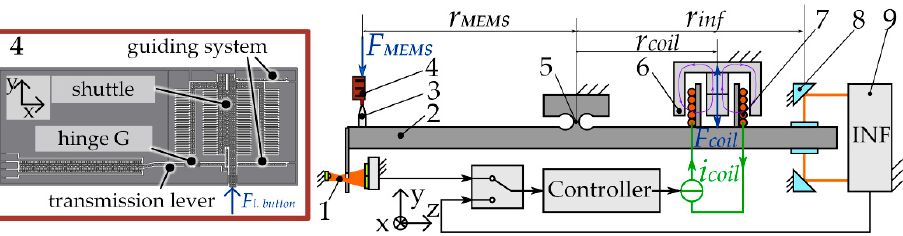
Figure 6. Illustration of the direct force measurement device used for measuring the stiffness of the MEMS-based weighing cell: (1) slit aperture; (2) beam balance; (3) loading button; (4) MEMS-based weighing cell chip; (5) joint; (6) permanent magnet; (7) coil; (8) deflection mirror; (9) interferometer.